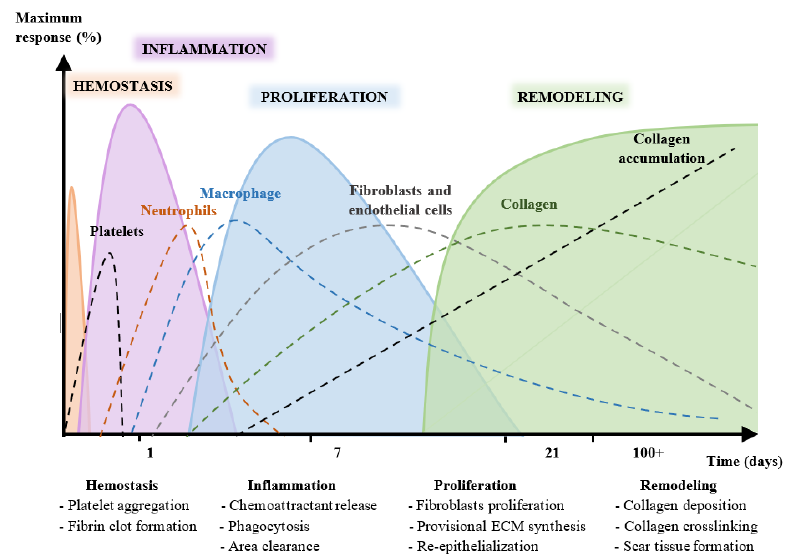
Figure 1. Stages of skin wound healing (hemostasis, inflammation, proliferation, and repair and remodeling) over time.